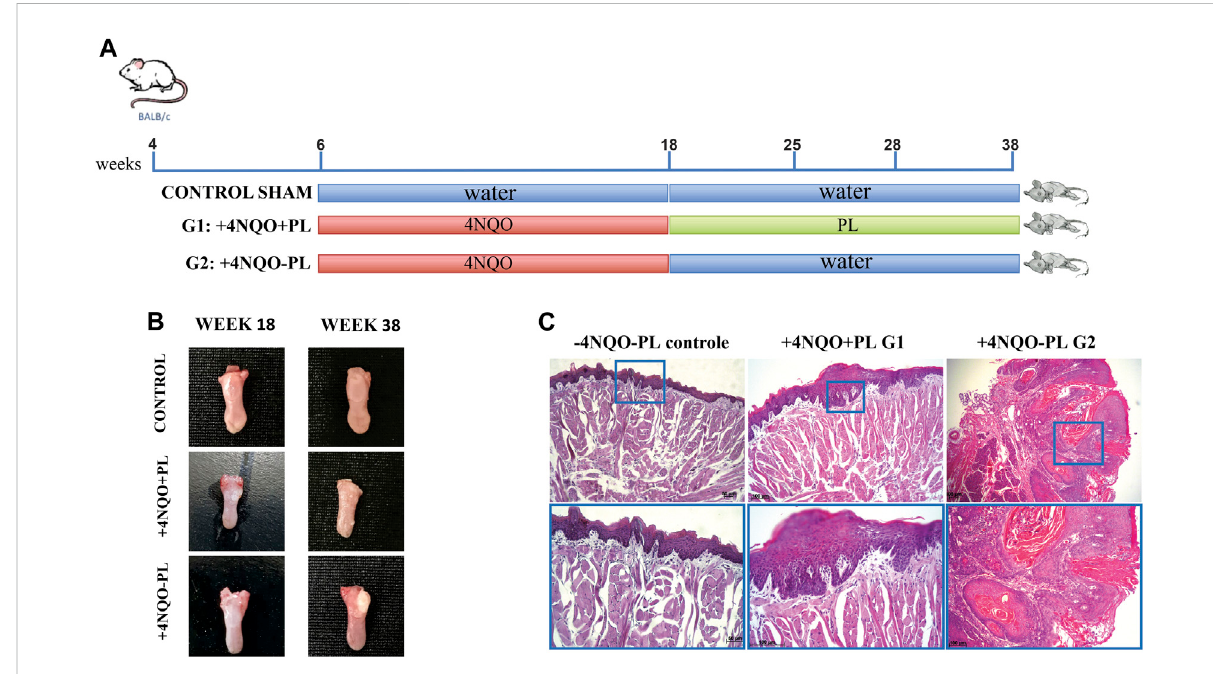
FIGURE 5 Representative photomicrographs of histopathological analysis of the tongue epithelium after carcinogenic induction and PL treatment. (A) Timeline of BALB/c mice chemical carcinogenesis induction by 4-NQO. (B) Macroscopy: representative tongue of control mice, which did not receive4NQOinduction,andwithouttonguelesion;thetongueofmiceinducedwith4NQOandtreatedwithPL(+4NAO+PL);andtongueofmice induced with 4NQO and not treated with PL (+4NQO-PL). (C) Histological microscopy: -4NQO-PL, normal mouse epithelium that did not receivechemical induction(control);+4NQO+PL,strati fi edepitheliumshowingmoderatedysplasia,representativeofanimals4NQO-inducedthat weretreatedwithPL;and+4NQO-PL,representativewell-differentiatedSCCofthemajorityofmicethatwere4NQO-inducedandwerenottreated withPL,showingintenseepithelialdysplasiainvolvingtheentirethicknessoftheepitheliumandareasoflossofbasementmembraneintegrity.Upper panel: photomicrographs at × 100 magni fi cation; lower panel: photomicrograph at × 200 magni fi